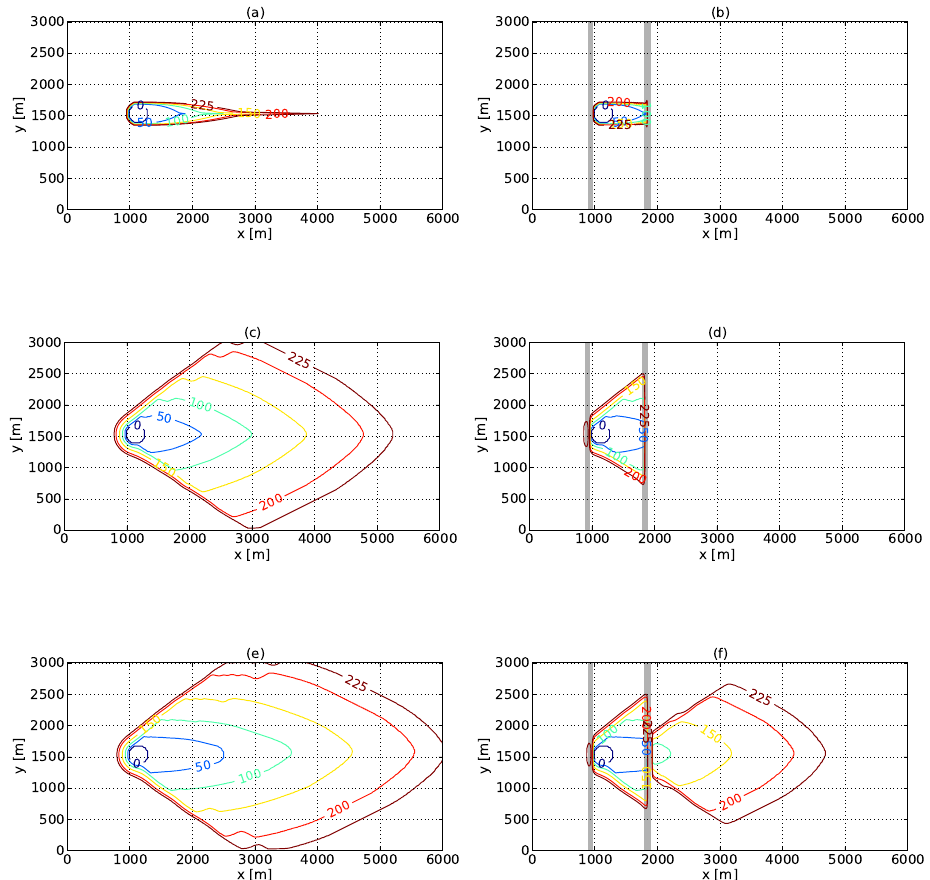
Figure 1. Time evolution of the firefront when the mean wind velocity and the fire intensity are U t =6.70ms − 1 and I =10000kWm − 1 (case A ), in the absence (on the left) and the presence (on the right) of two fire-break zones (grey stripes) located on the left and on the right of the initial firefront. The results are obtained by adopting the level-set method (top row panels) by the present modelling approach when only turbulence is taken into account (middle row panels), and when both turbulence and fire spotting are considered (bottom row panels). The labels on the contour lines represent the propagation time (expressed in minutes). All the parameters of the model are given in Table 1.